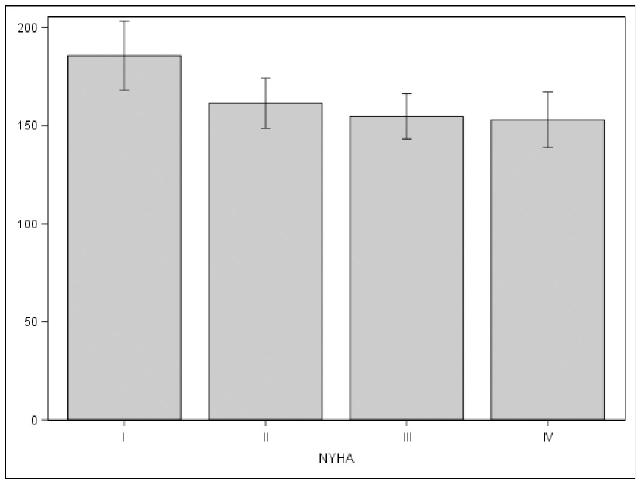
Fig 2. Relationship between NYHA class and the PELC questionnaire score expressed as means (95% confidence interval; p = 0.04).